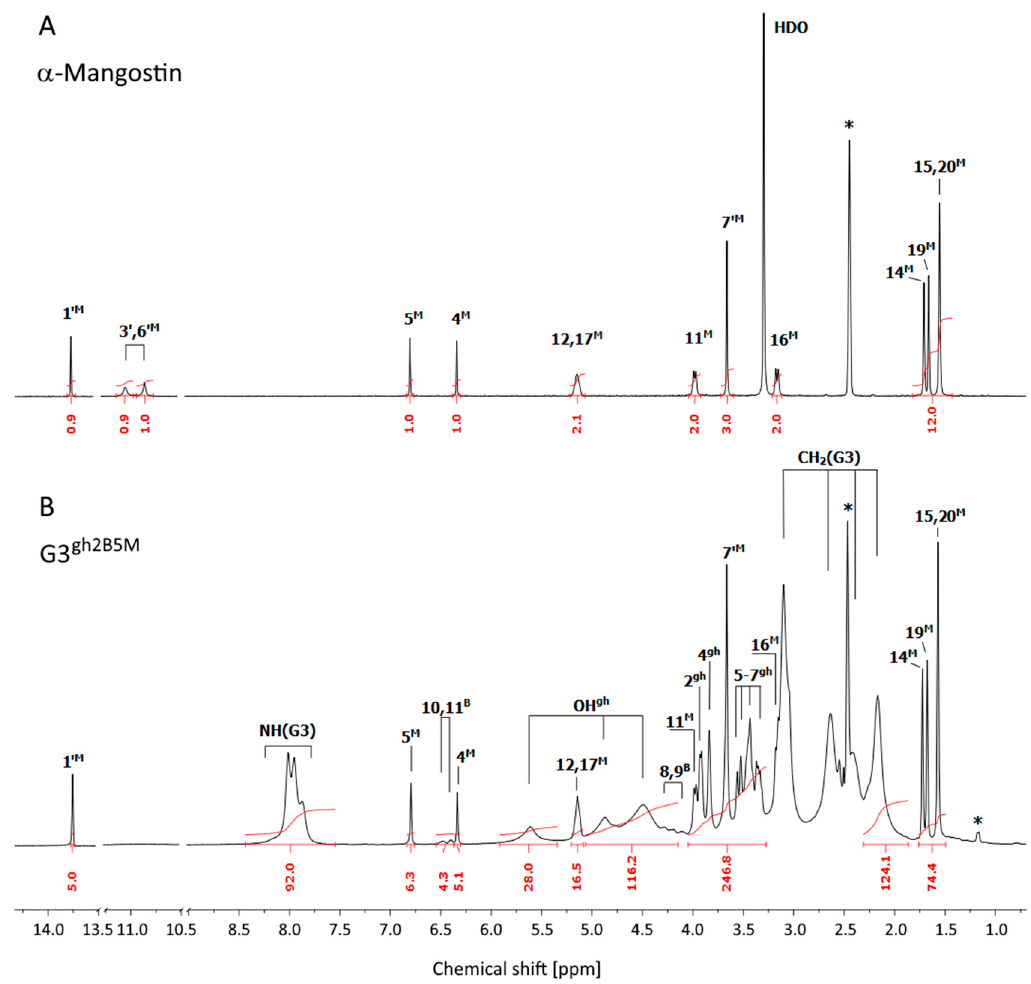
Figure 1. The 1 H NMR spectra of α -mangostin ( A ) and G3 gh2B5M conjugate ( B ) in DMSO-d 6 . The residual solvent peak at 2.5 ppm and impurity resonances are marked with asterisks *. The PAMAM G3 core dendrimer resonances are labeled as CH 2 (G3) and NH(G3) in spectrum B. The resonances of α -mangostin, biotin, and glucoheptoamide are labeled by locants with M , B , and gh upper indexes, respectively, according to the atom numbering in Scheme 2. The 1A spectrum was taken from [29].